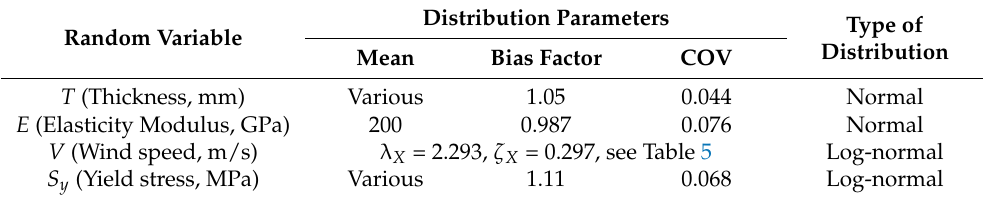
Table 8. Probabilistic models of the random variables used in the reliability